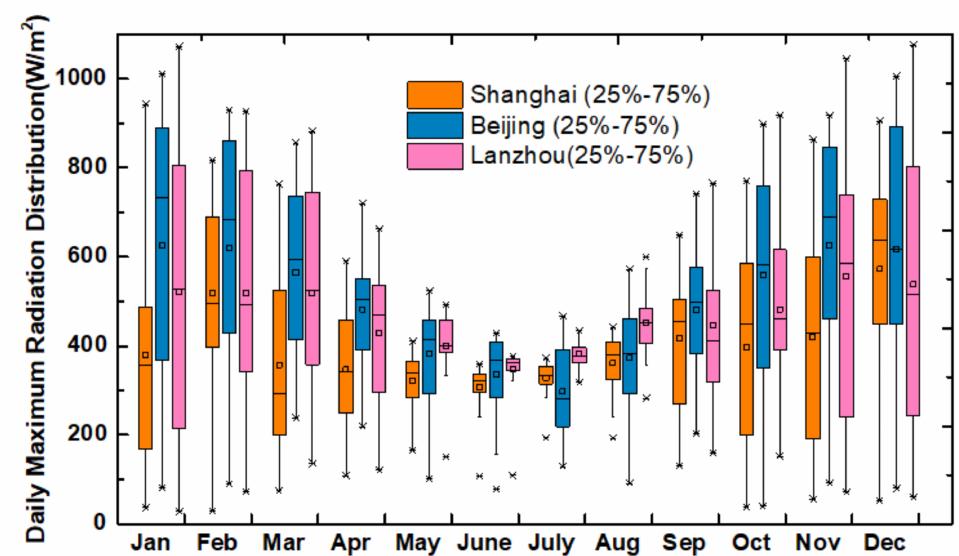
Figure 4. Monthly distribution of daily maximum radiation for the three